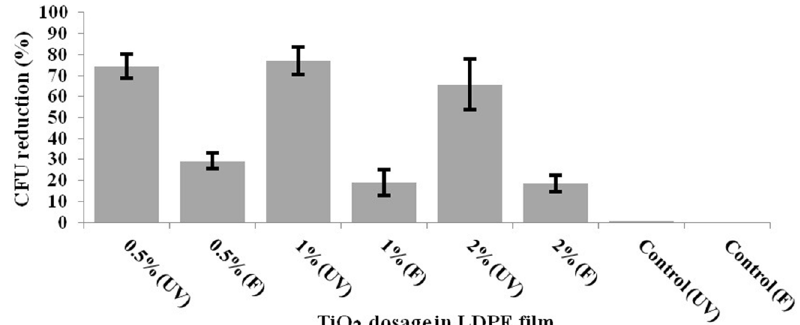
Fig. 2. Direct bactericidal effects of TiO 2 NPLs loaded LDPE films on S. aureus after 72 hr in the presence of fluorescent and UV lights at 20 o C